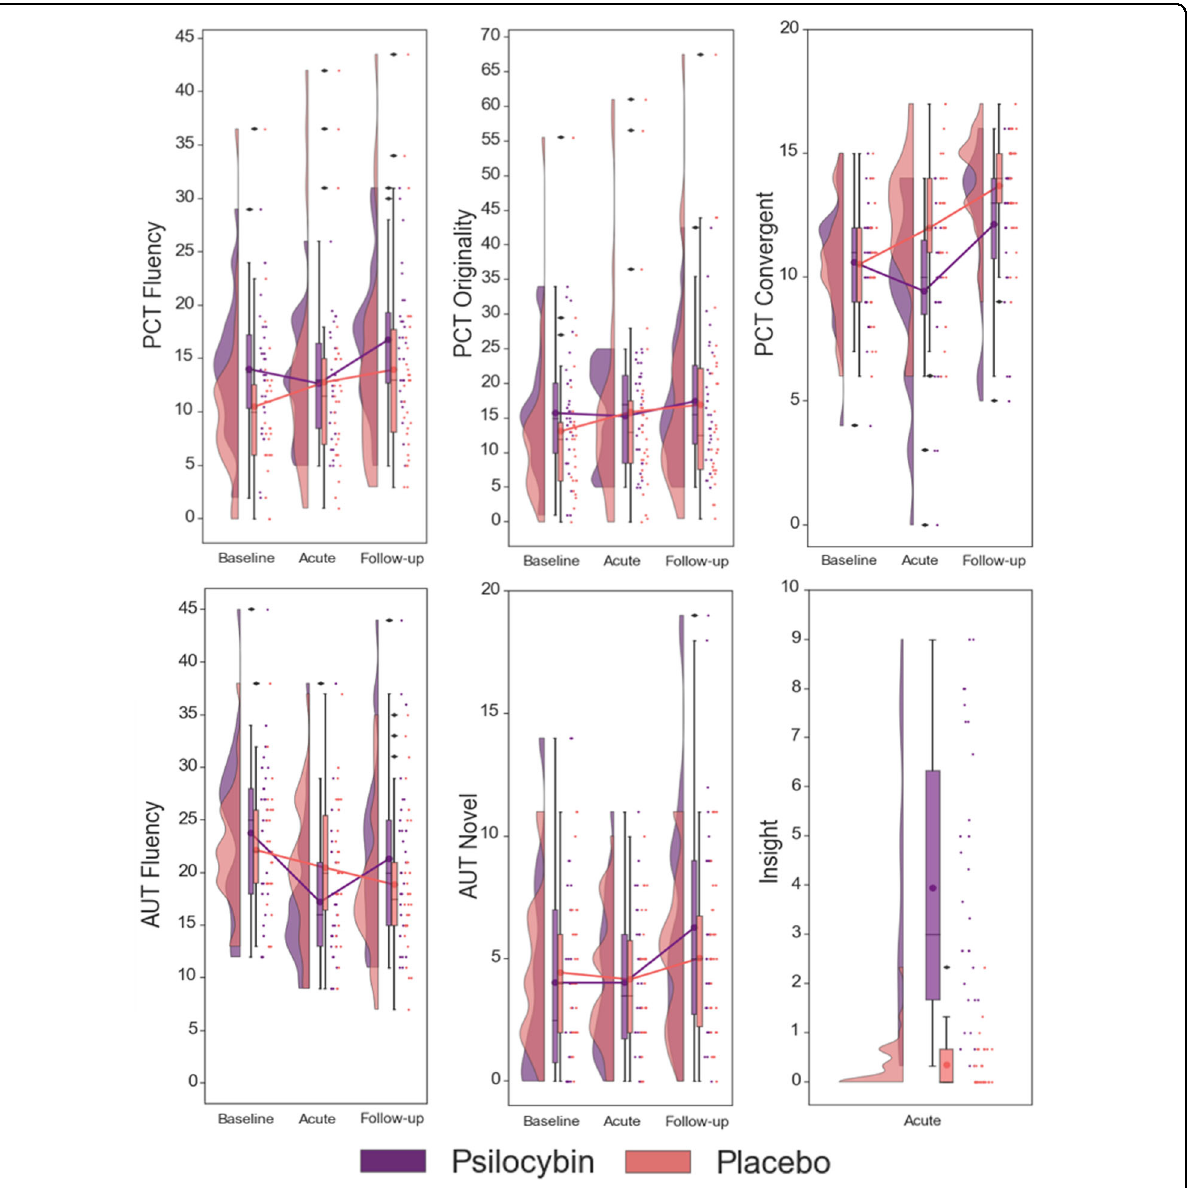
Fig. 1 Raincloud plots displaying scores on measures of creativity, which demonstrated signi fi cant differences between treatment groups. The plot consists of a probability density plot, a boxplot, and raw data points. In the boxplot, the line dividing the box represents the median of the data, the ends represent the upper/lower quartiles, and the extreme lines represent the highest and lowest values excluding outliers. The code for raincloud plot visualization has been adapted from Allen et al. 108